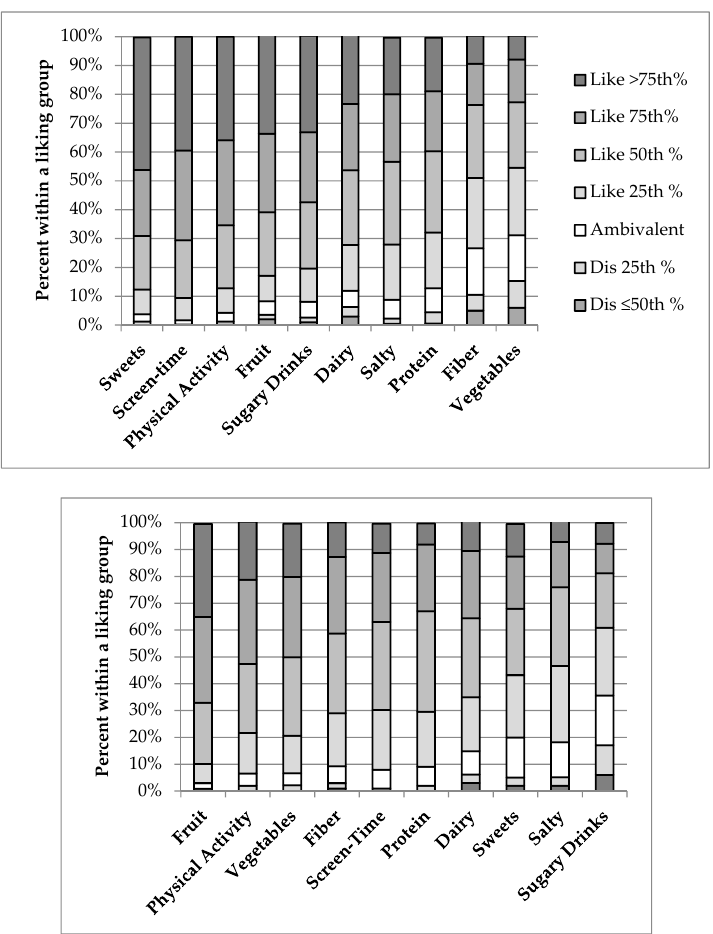
Figure 1. Liking of food/beverage and activity groups (left to right as most to least liked) in children (top graph) and parents (bottom graph), shown as percent within a food or activity group as liking (above the white neutral rating) and disliking (below the white neutral rating), with the darker the shading indicating stronger the liking or disliking. Table 4. Variance and estimated effect sizes of child ( n = 925) and parent ( n = 925) survey-reported liking of foods and activities.